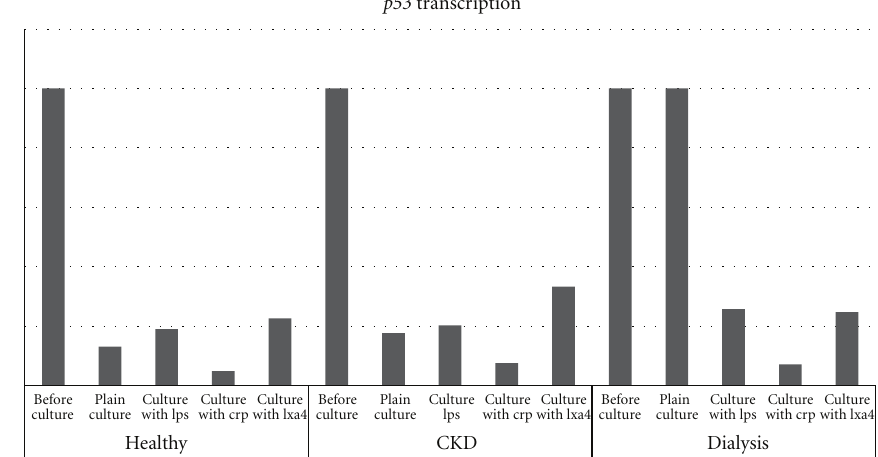
Figure 1: Expression status of p53 in every condition studied. As the disease advances and especially in the dialysis group, the gene’s transcription levels become higher in the corresponding cultures. The columns of this particular figure are derived from the pair wise comparisons depicted on Table 2.